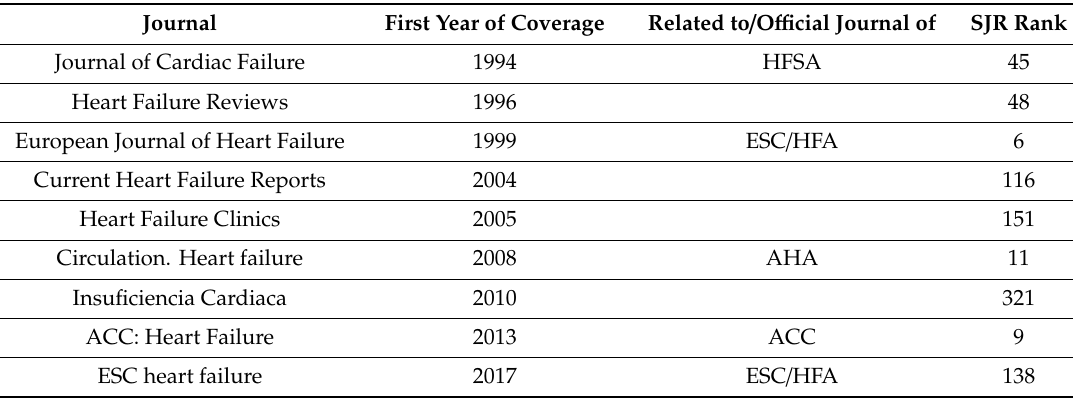
Table 3. New foundations of heart failure